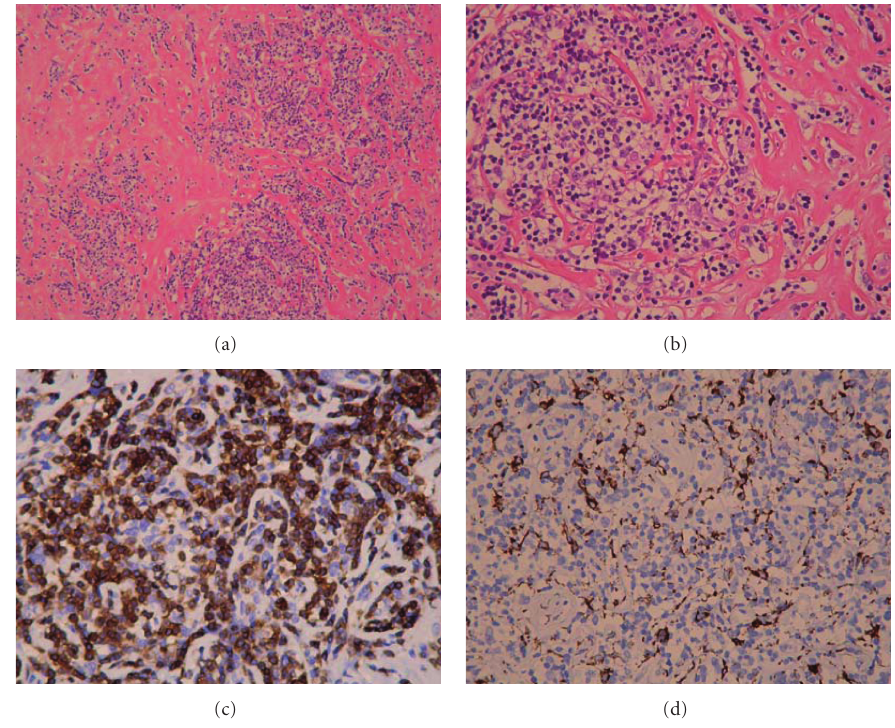
Figure 5: Low (a) and high (b) magnifications of hematoxylin-eosin-safron stained sections showing nodular cellular infiltrates with abundant fibrosis; immunohistochemistryrevealing a prevalence of CD3-positive T lymphocytes (c) and someCD68-positive histiocytes